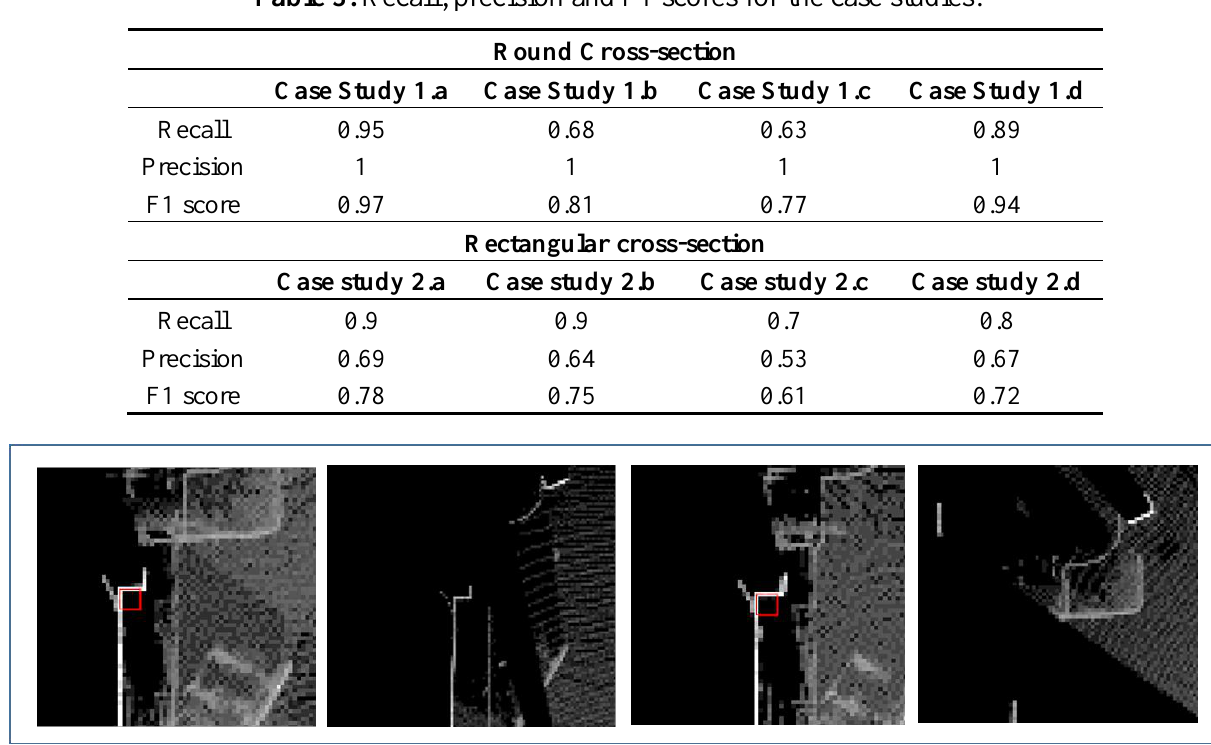
Figure 11. Wall corners can be detected as rectangular cross-section columns being false positives. The results are shown over the raster